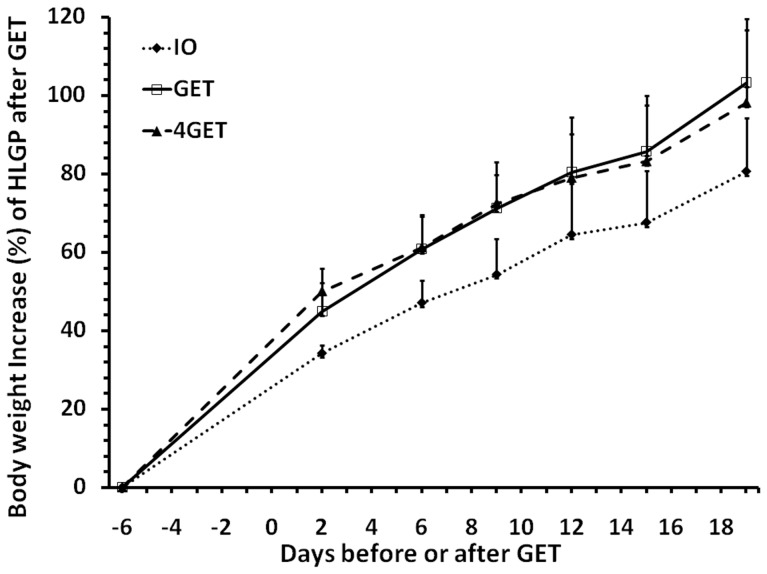
Body weight increase of HLGP after i.d. DNA injection and non-invasive GET.Delivery group, IO: 50 µL DNA without pulse delivery; GET: 50 µL DNA with 1 pulse delivery on the injection site; 4GET: 4 injections with 50 µL DNA and each pulse delivery on the injection site. Bars represent mean ± SD. 4 animals were analyzed for each delivery group. * p<0.05 for 4GET or GET vs IO by One Way RM-ANOVA.